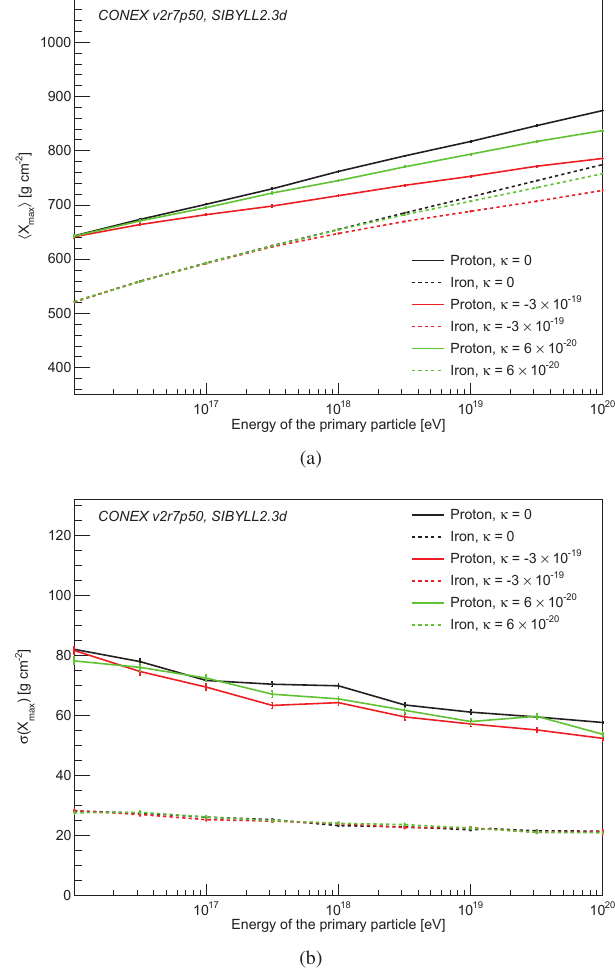
Figure 1. (cid:3) X max (cid:4) and σ ( X max ) as a function of the primary en- ergy for primary protons and iron nuclei for the absence of LV ( κ = 0) and for di ff erent vaues of κ . All lines were obtained from CONEX simulations using the hadronic interaction model SIBYLL